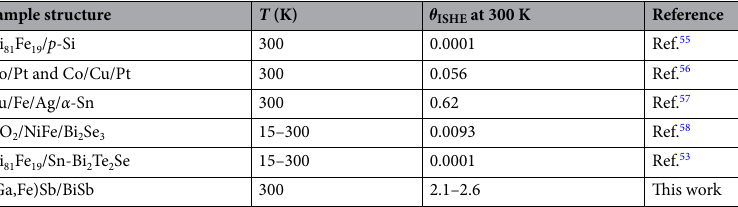
Table 3. Comparison of the spin-to-charge conversion efficiency between our sample with other heterostructures. T is a temperature at which ISHE voltage signals were measured and θ ISHE is the spin-to- charge conversion